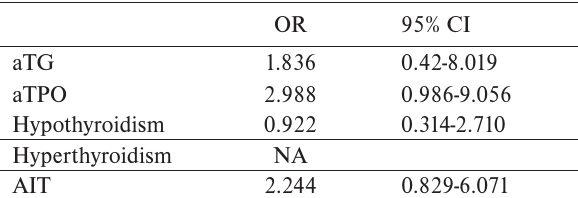
Table 4. The relative risk for positivity of aTG and aTPO in patients with PCOS in comparison with healthy